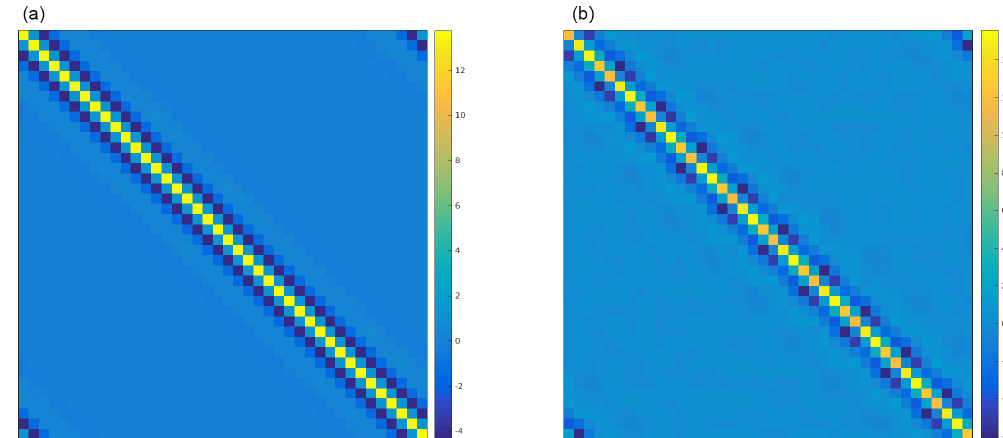
Figure 4. Calculated optimal single-time and time-averaged covariance matrices for the multivariate Lorenz’96 model. Comparison of ensemble covariance matrices for the multivariate Lorenz’96 equations for a single time step (a) with that for a time-averaged run (b) for 100000 and 10000 ensemble members, respectively.